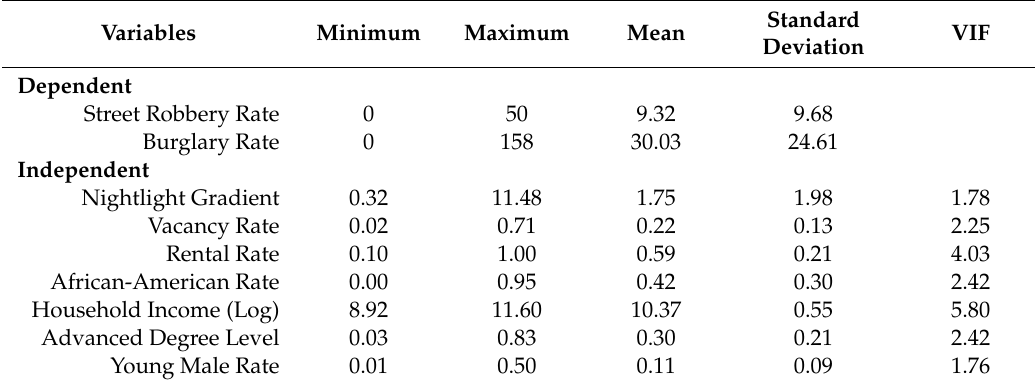
Table 4. Descriptive information of